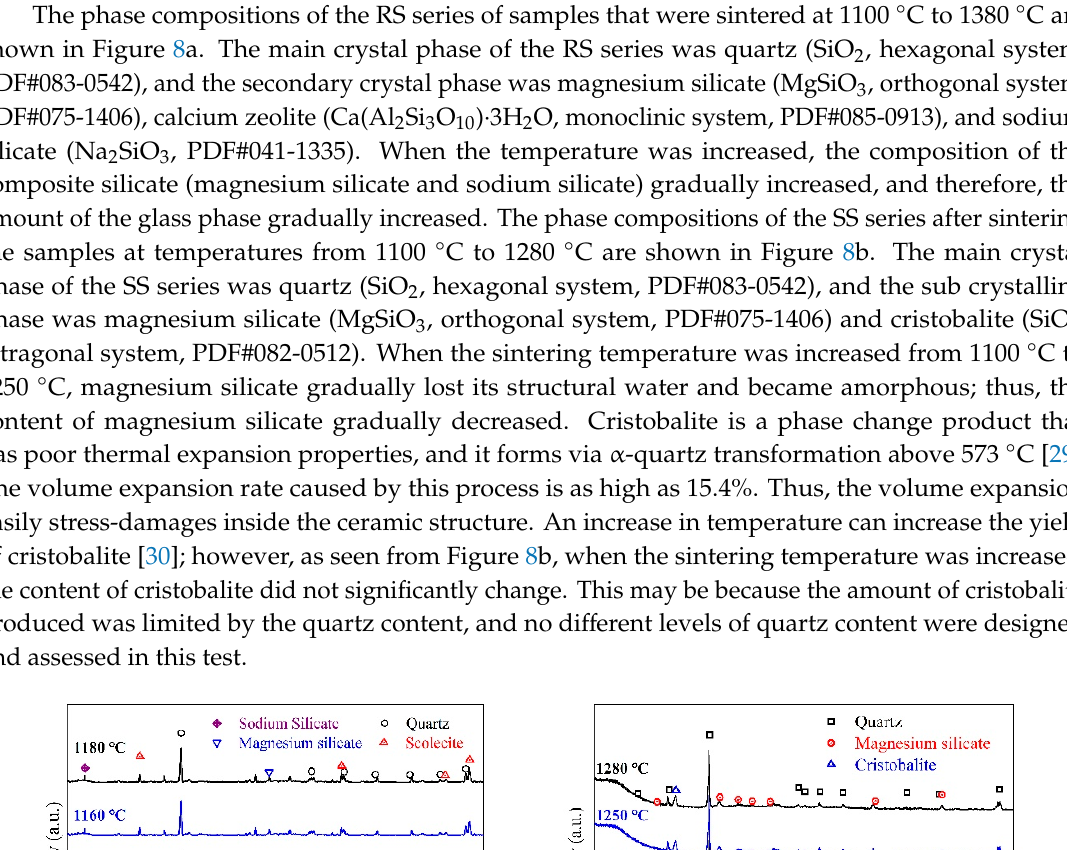
Figure 8. XRD patterns of ( a ) RS and ( b ) SS sintered samples at different temperatures.